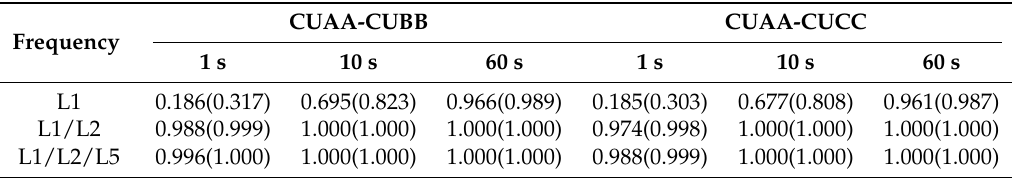
Table 2. Empirical and average formal IB ASRs (in brackets) for the phase-only two-epoch scenario. The data on DOY 240, 2018, was used for the